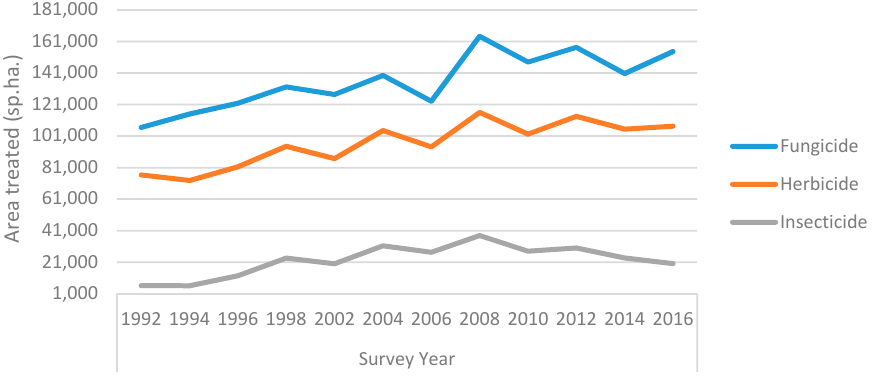
Figure 4. The application area (sp.ha.) of arable crops in Northern Ireland treated with the major pesticide groups 1992–2016. Agriculture 2018 , 8 , x FOR PEER REVIEW